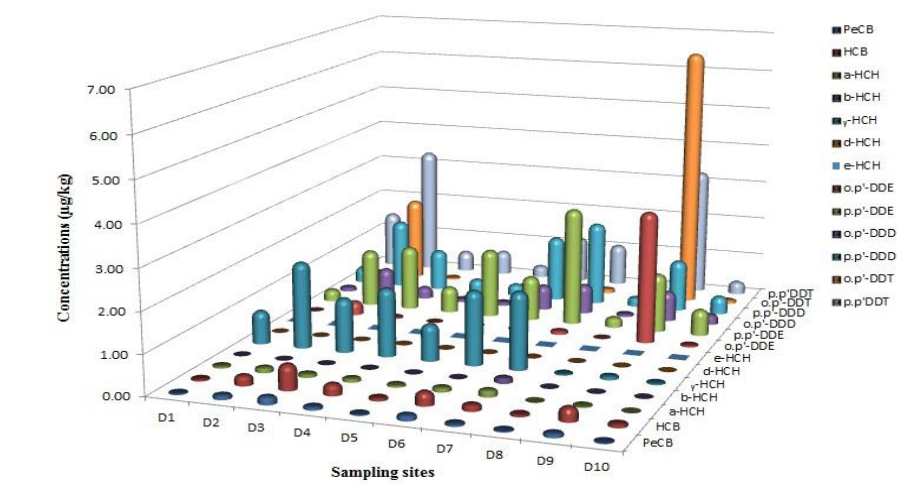
Figure 4. Spatial distribution of total OCPs in sediment